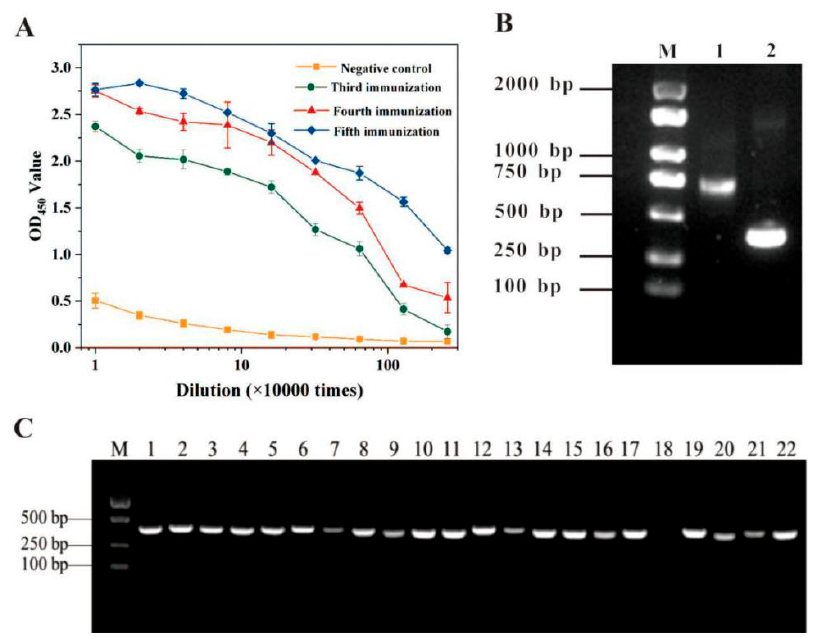
Figure 1. SEC-specific Nb library construction. ( A ) Anti-SEC serum via indirect ELISA. ( B ) The VHH genes were acquired via two-step PCR and run on an agarose gel. The initial fragments of the PCR display a band at approximately 750 bp. Secondary PCR was used to amplify the Nb genes, showing a 400 bp band. ( C ) The randomly selected 22 individual clones for estimating the appropriate insertion rate using colony PCR.